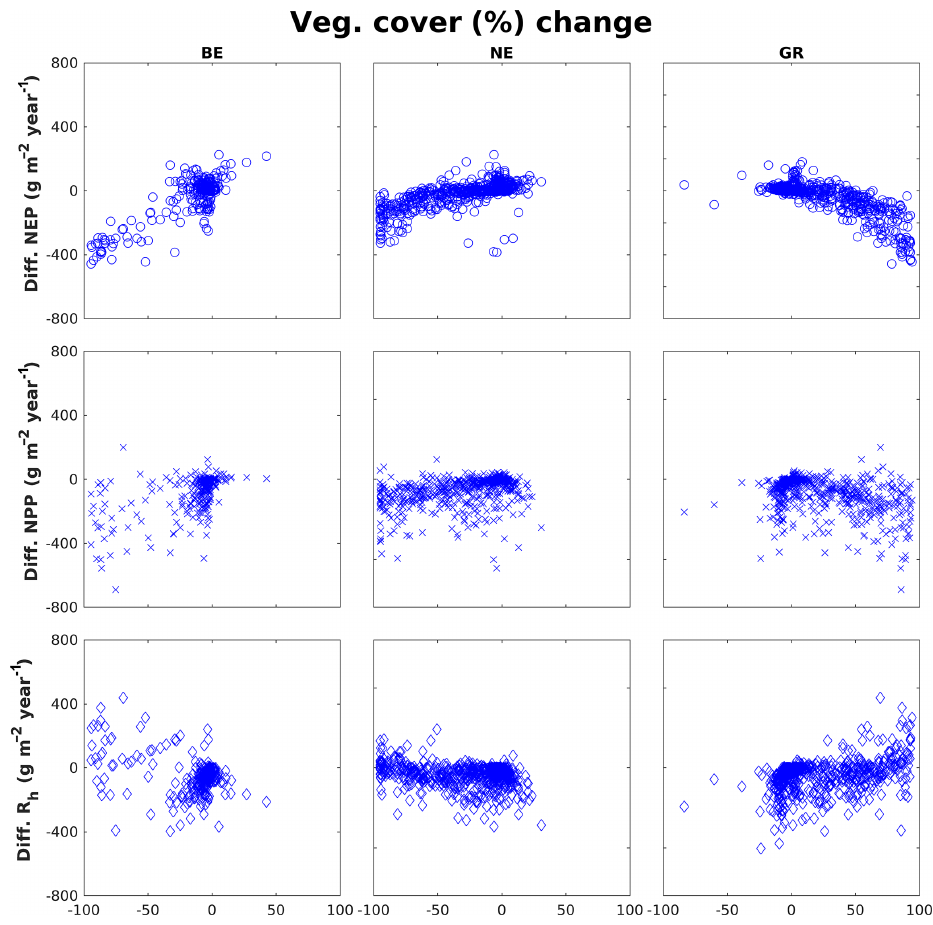
Figure 7. Differences in net ecosystem production (NEP), net primary productivity (NPP), and heterotrophic respiration ( R h )) due to fires in BGC-DV (i.e., BGC-DV-F minus BGC-DV-NF) according to percent changes in broadleaf evergreen (BE), needleleaf evergreen (NE), and grass (GR) vegetation